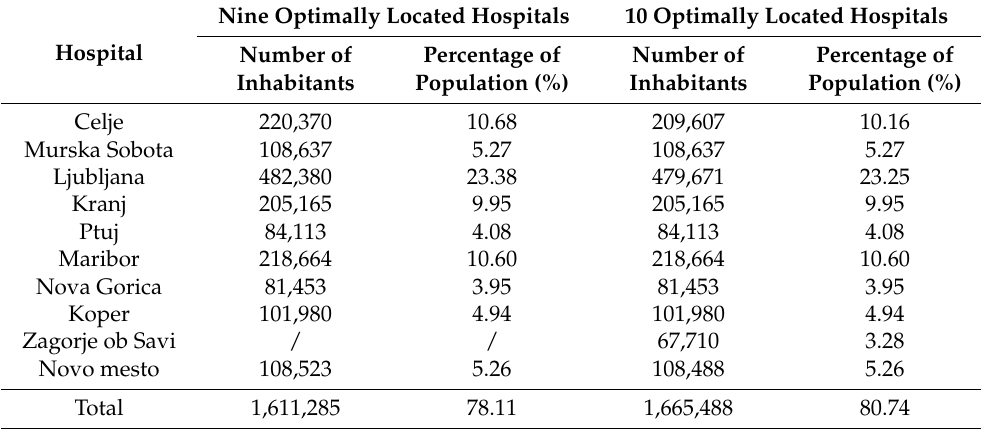
Table 1. Number of general hospitals and a coverage rate of the population within the 30-min time